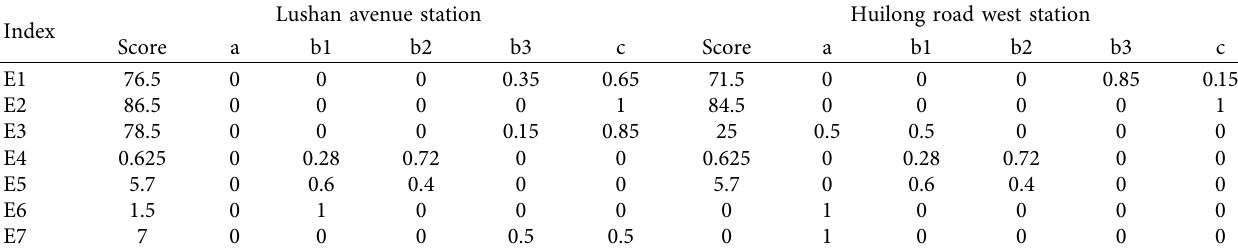
Table 6: The results of seven indicators’ five-element contact numbers by the SPA.